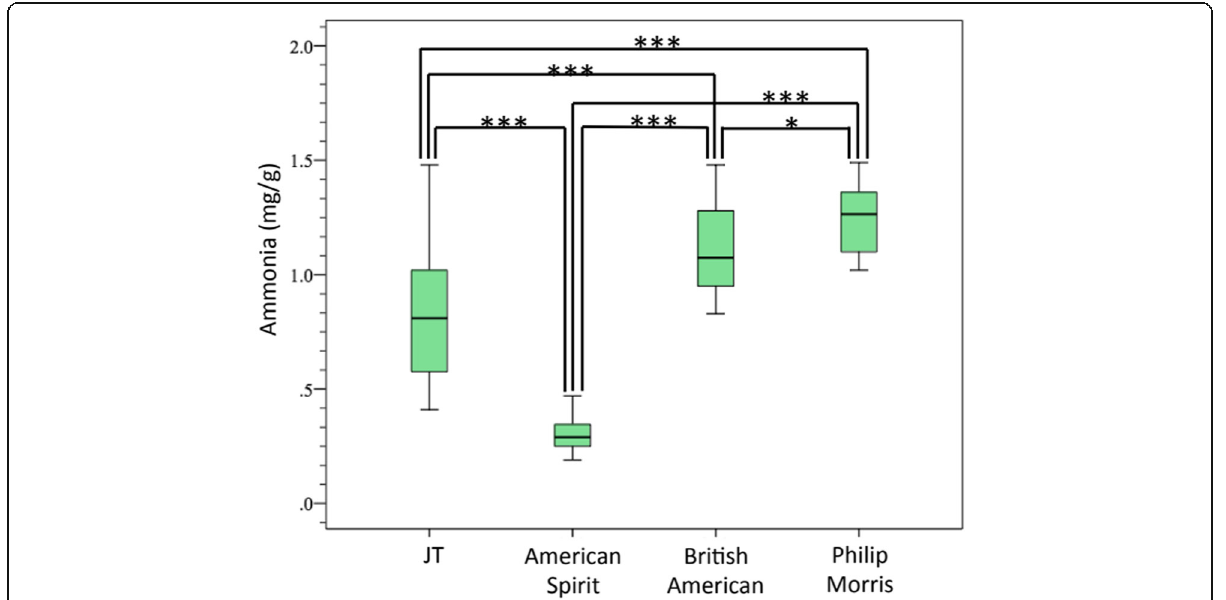
Fig. 3 Ammonia levels in the tobacco filler of commercially marketed cigarettes in Japan (manufactured by Japan Tobacco Inc. (JT), Natural American Spirit, British American Tobacco, and Philip Morris Japan). The differences between the ammonia levels in cigarettes of different companies were analyzed by one-way ANOVA, followed by the Bonferroni post hoc test (* p < 0.05, *** p < 0.001)